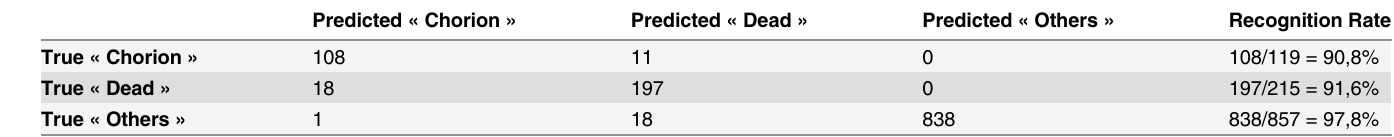
Table 6. Summary of the classi fi cation results on validation set after being classi fi ed by the Two-tier